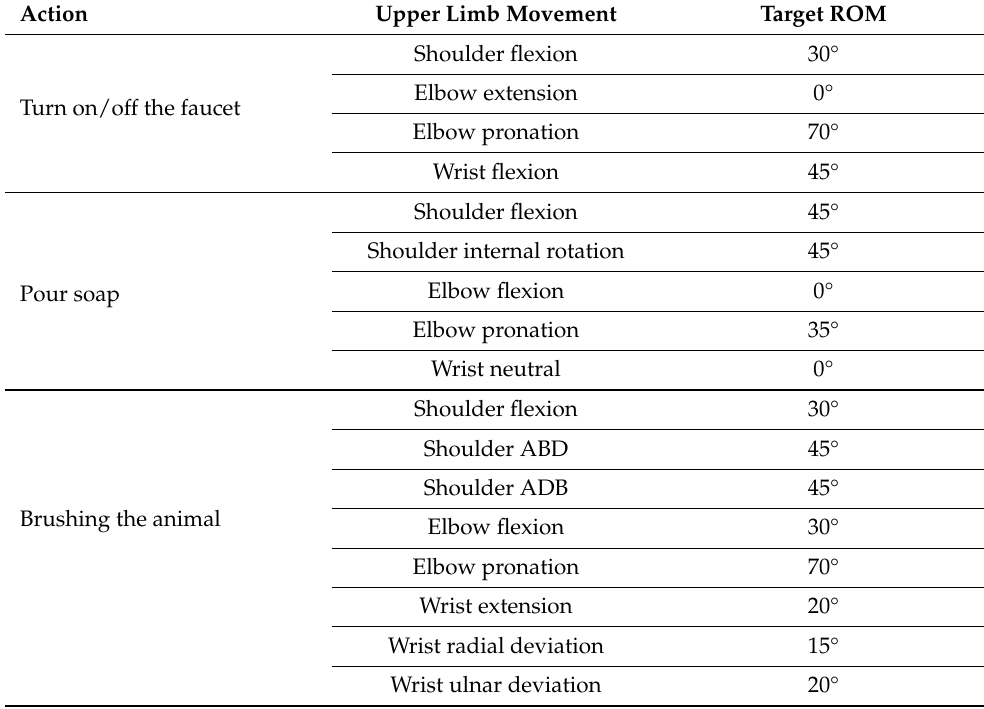
Table 4. Sequence of actions and the upper limb movements involved in the animal caring activity. Action